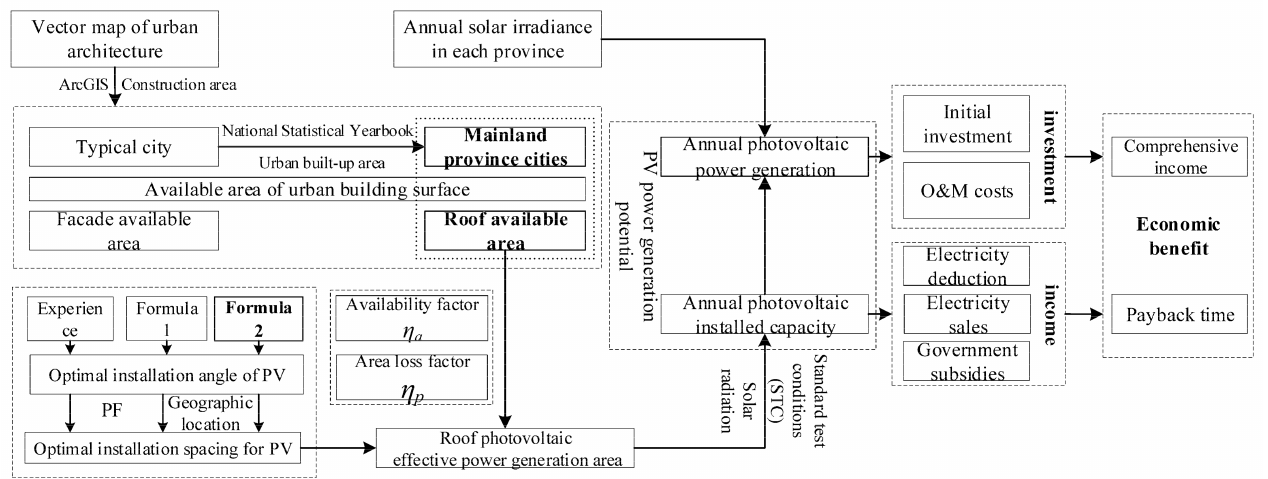
Figure 1. Overview of the methods used in